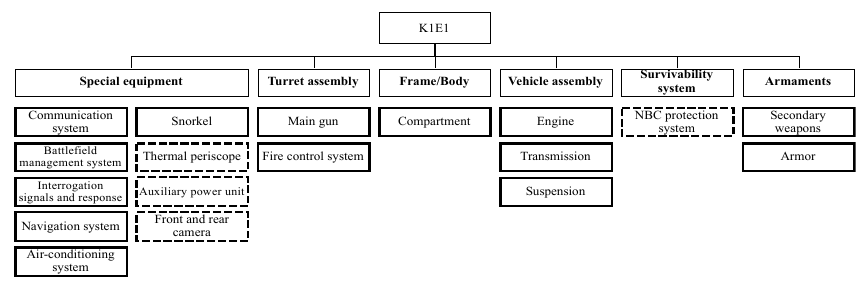
Figure 9. Module-based representation of K1E1 main battle tank (MBT).